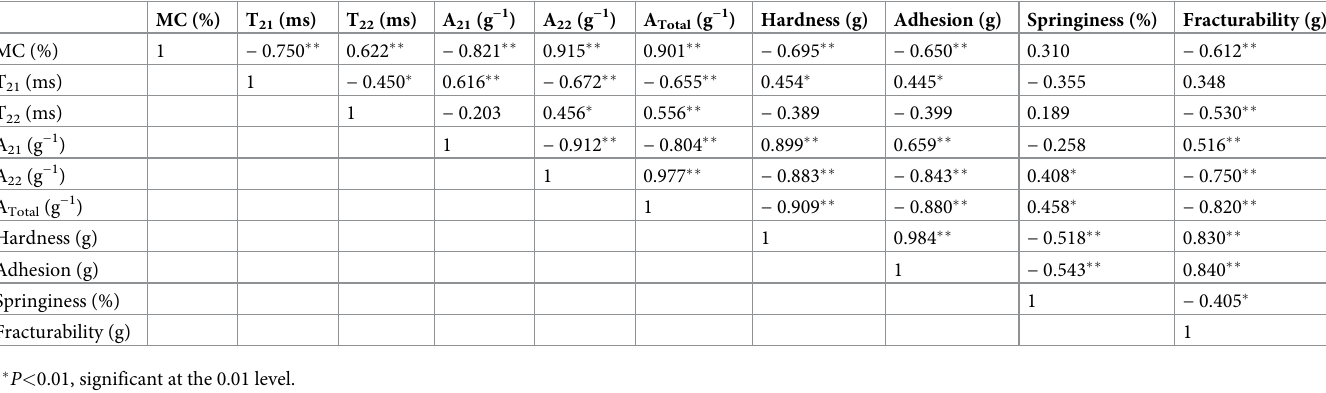
Table 4. Correlation coefficients for moisture content (MC), LF-NMR and texture